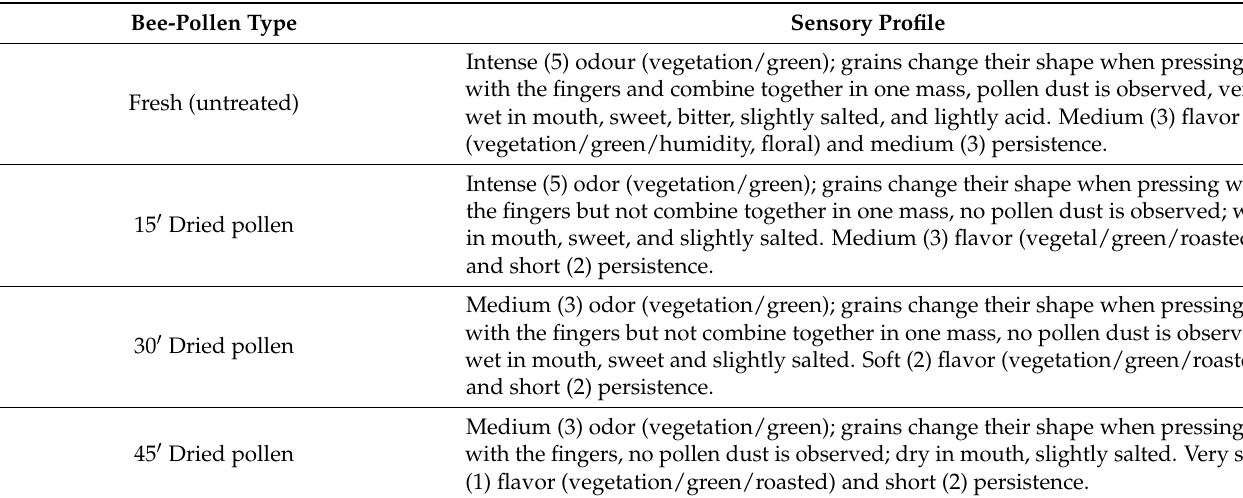
Table 6. Sensory profiles of fresh and hot-air dried